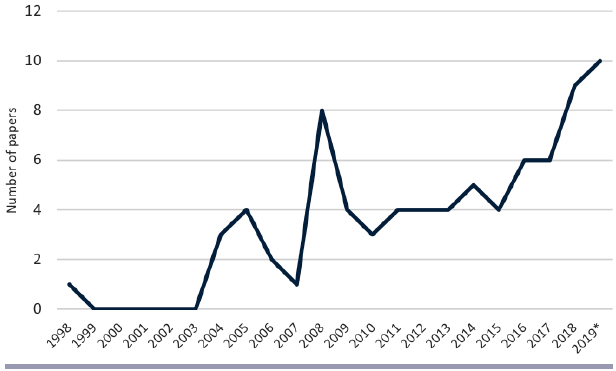
Fig. 1 . Number of papers within literature on Indigenous peoples and environmental monitoring. Literature published up to November 2019 was reviewed.